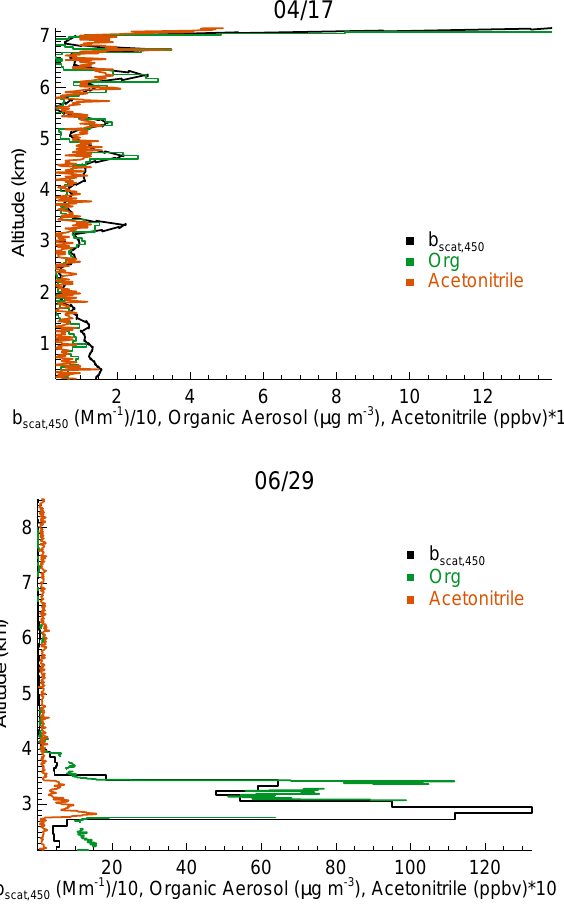
Fig. 2. Vertical profiles of b scat , 450 (black), organic aerosol (green), and acetonitrile (orange) for 17 April (top) and 29 June (bottom) spiral